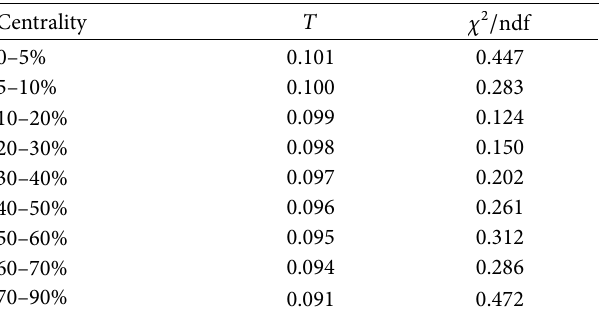
Table 1: Values of parameters used in Figure 1(a). The unit of 𝑇 is GeV .